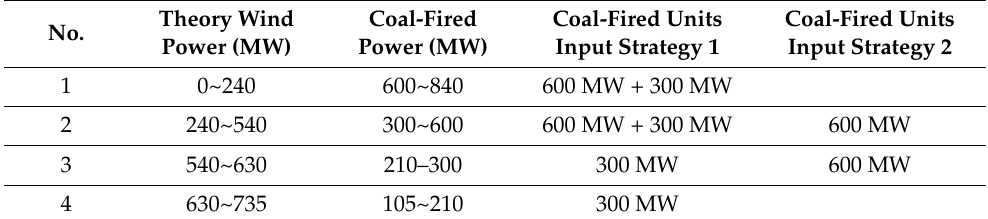
Table 2. Operation strategies of the 840 MW wind–coal combined base load power generation system.